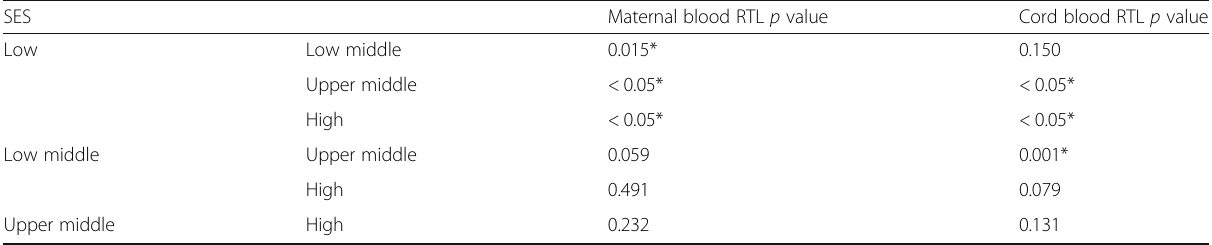
Table 2 Secondary analysis (pairwise) between SES and maternal and cord blood RTL SES Maternal blood RTL p value Cord blood RTL p value Low Low middle 0.015* 0.150 Upper middle < 0.05* < 0.05* High < 0.05* < 0.05* Low middle Upper middle 0.059 0.001* High 0.491 0.079 Upper middle High 0.232 0.131 The Kruskal-Wallis test (pairwise) was used to find the mean difference between RTL and different socioeconomic groups *Significant